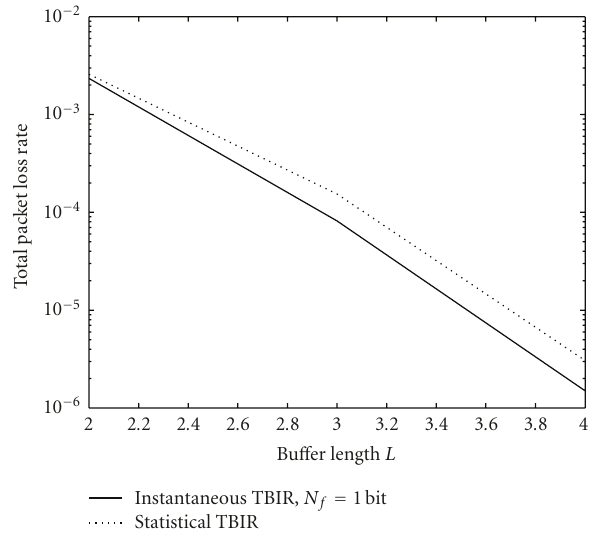
Figure 6: Variation of average packet loss with bu ff er length for statistical TBIR (dotted lines) and one bit of instantaneous TBIR (solid lines) is